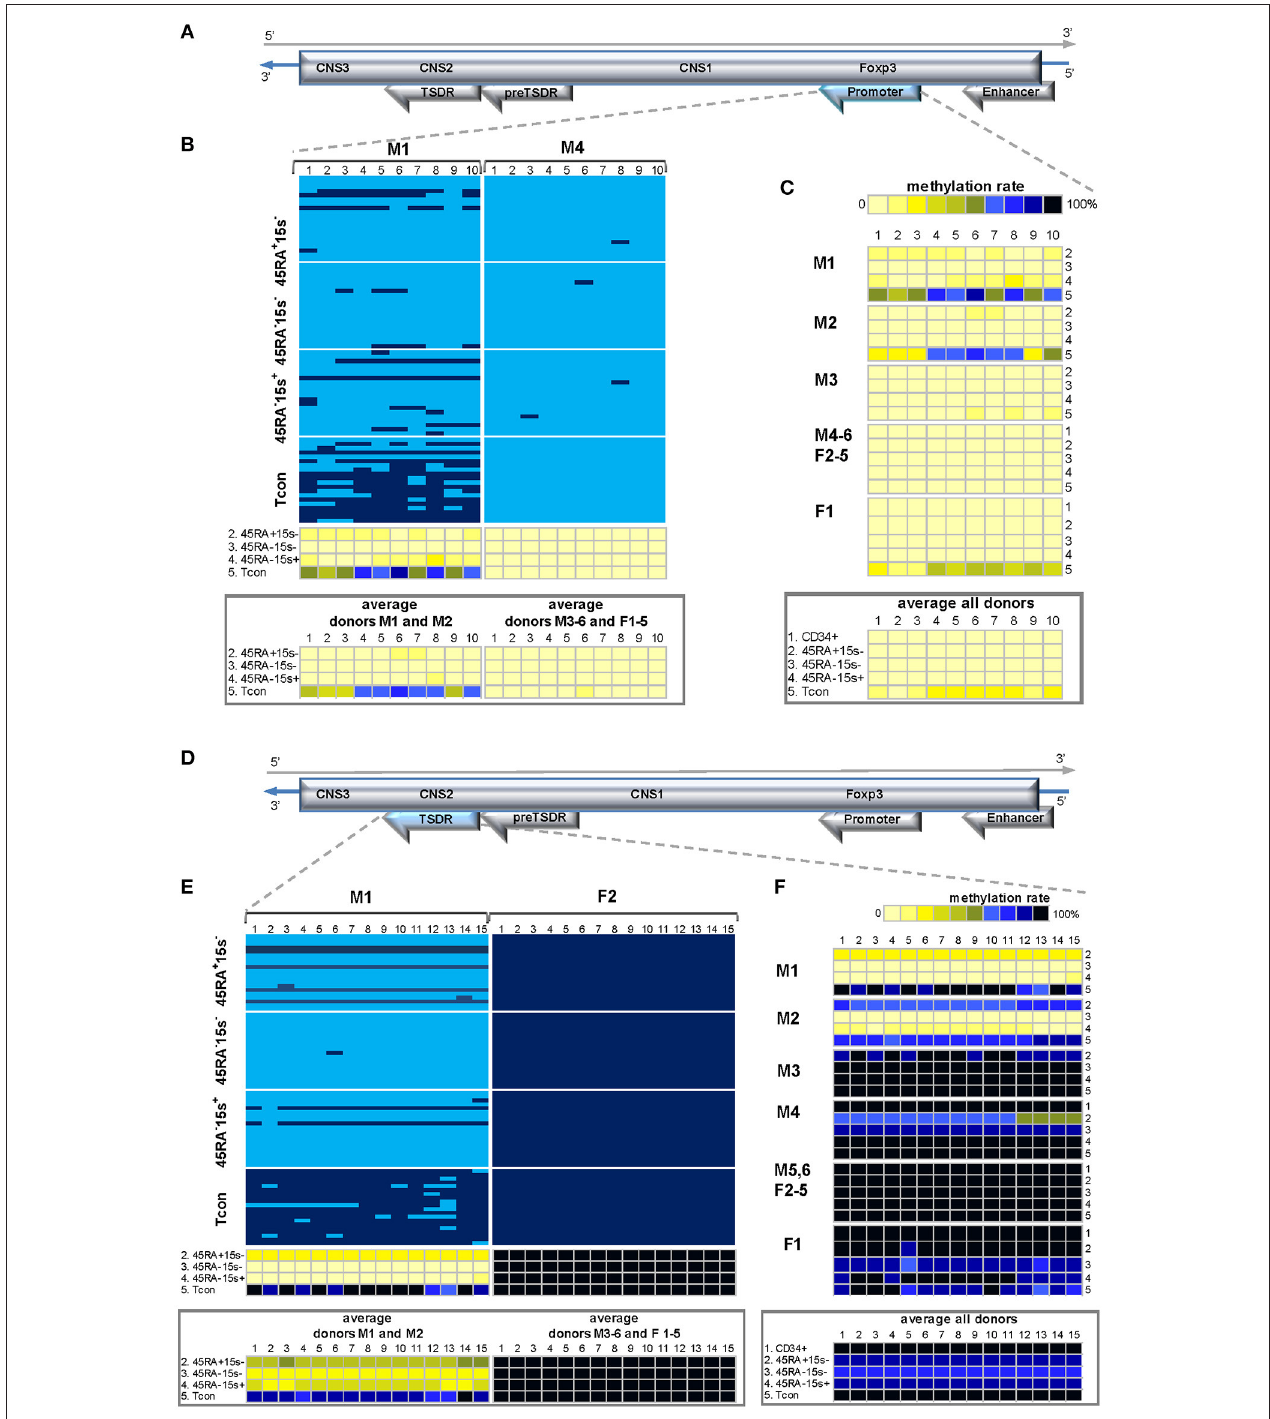
FIGURE 6 | Methylation patterns of the FOXP3 promoter and TSDR. FOXP3 TSDR region is methylated within the coding (reverse) strand while promoter remains demethylated in several donors of both genders. (A,D) Schematic presentation of the FOXP3 promoter (A) and TSDR (D) encoded in the reverse strand of Xp11.23. (B) and (E). Methylation patterns of the FOXP3 promoter (B) and TSDR (E) in five cell populations: CD34 + (1), CD45RA + CD15s − (2), CD45RA − CD15s − (3), CD45RA − CD15s + (4), and Tcon (5) of representative donors M1 (B,E) and M4 and F2 (B,E) . Average methylation percentages for the donors following methylation patterns of the presented donors are summarized in panels below each representative donor. CpGs 1-10 (promoter) and 1-15 (TSDR) are numbered relative to the 5 ′ -3 ′ direction of the coding (reverse) strand. Each horizontal line represents DNA from one cell with unmodified C in light blue and m C in dark blue. Methylation percentage for each CpG site was calculated based on the number of m Cs in a total of 20 and summarized in panels below. (C,F) Methylation patterns of the FOXP3 promoter (C) and TSDR (F) of individual donors with the average methylation pattern for all donors presented in panels below. See also Supplementary Figures 1 , 6 .